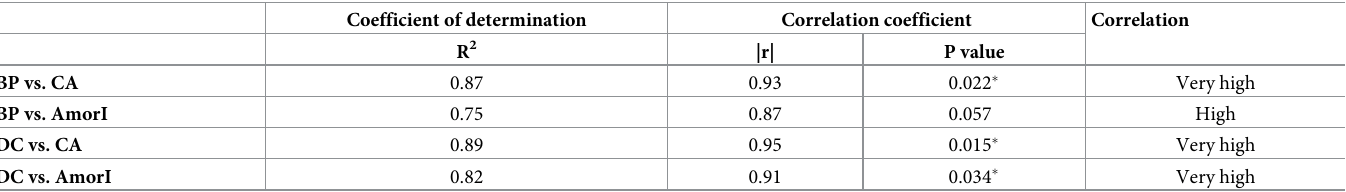
Table 7. Degree of linear fitting and correlation among the extracted DNA, AmorI, and CA in BP and